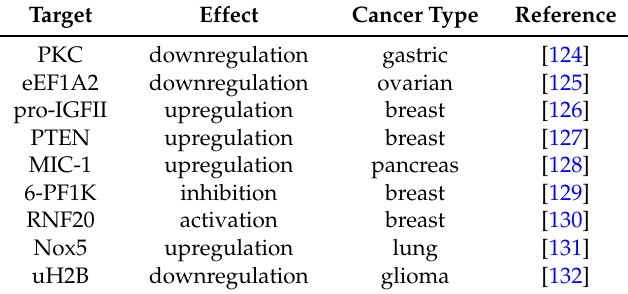
Table 2. Antiproliferative targets for resveratrol.